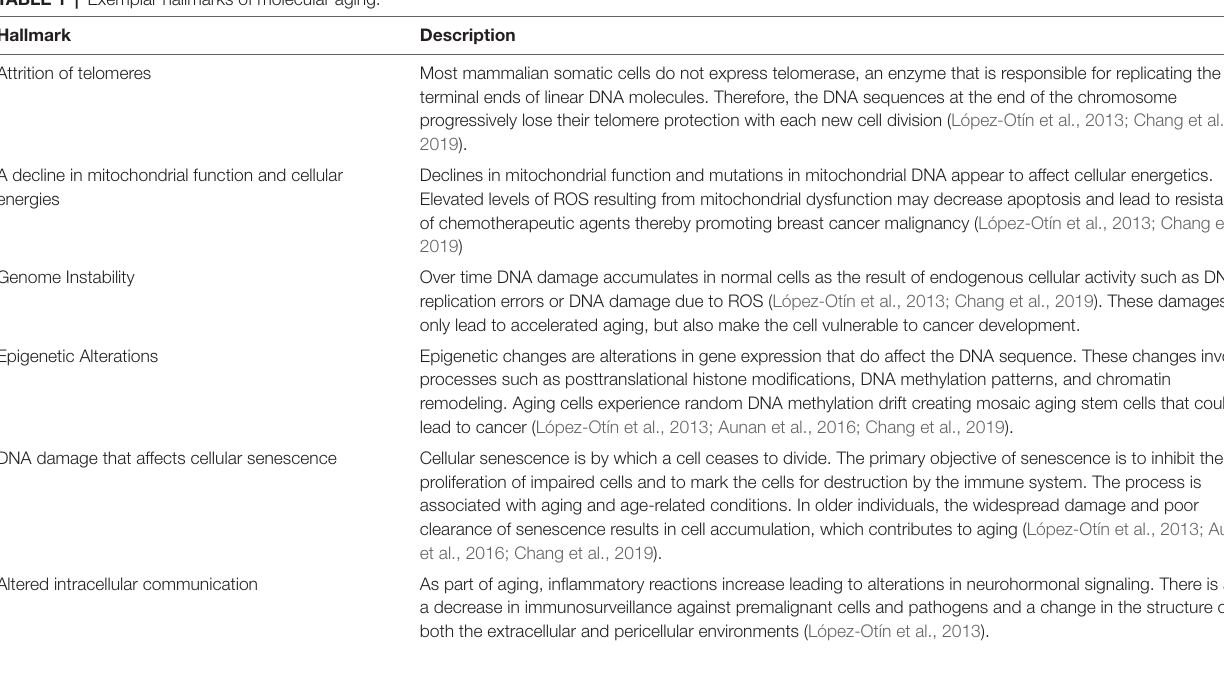
TABLE 1 | Exemplar hallmarks of molecular